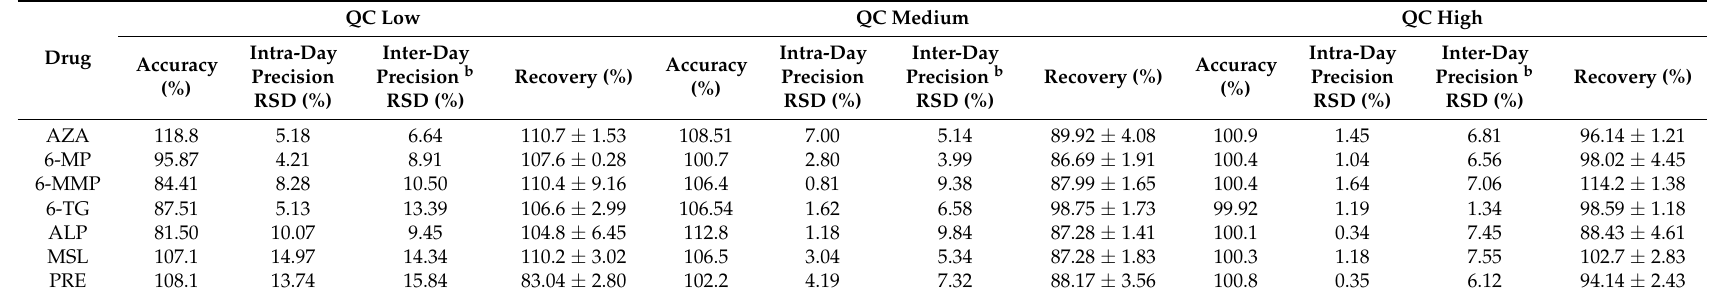
Table 3. Evaluation of spiked urine samples (QC samples) for estimation of precision and accuracy of the CE-ESI-MS/MS method a